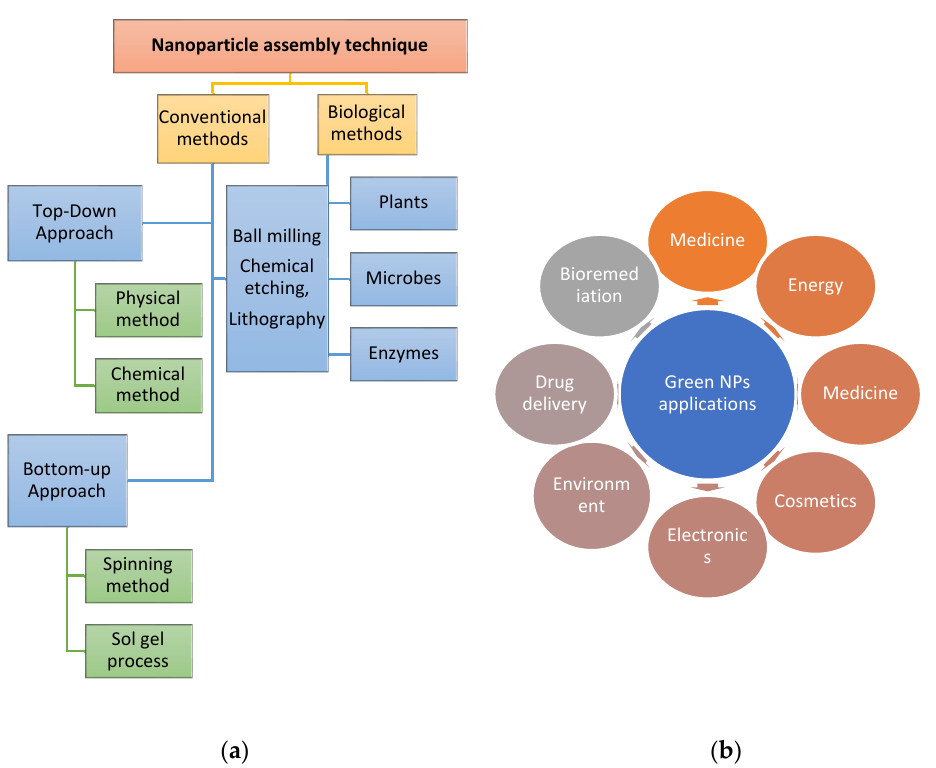
Figure 2. Classification of different nanoparticle synthesis methods ( a ) and their applications ( b ).